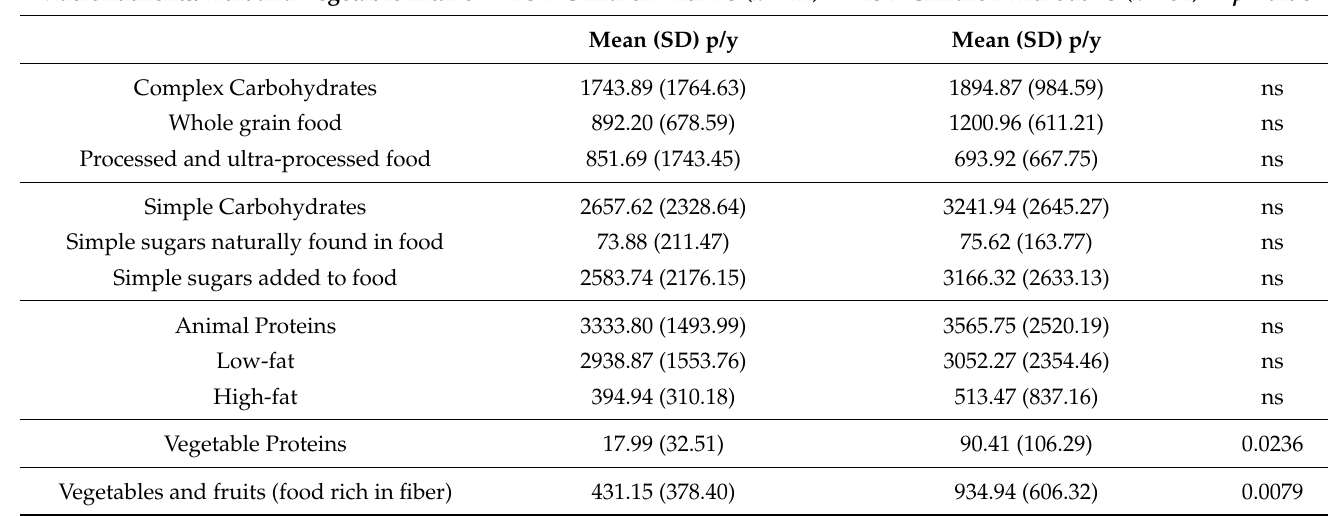
Table 6. Comparison of annual intake of macronutrients/fruit and vegetable intake between children with ASD with and without FS. Mean values are expressed in